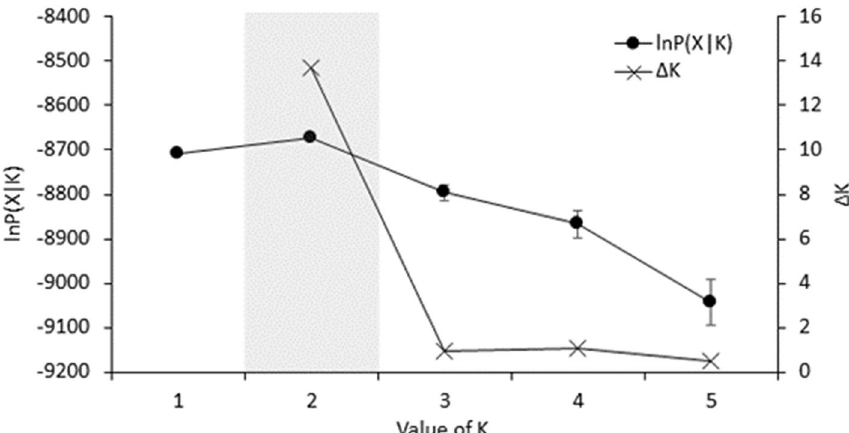
Figure 2. lnP(X|K; ± S.E.) and ΔK, as obtained in STRU CTU RE version 2.3.3, with K ranging from 1 through 5. Burn-in period was set to 50,000 simulations followed by 100,000 repetitions. Each value was obtained by averaging the posterior probabilities of 10 independent runs. Shaded region highlights the optimal value of K based on both approaches. Estimation of the optimal number of genetic clusters based on the Bayesian clustering analysis performed in STRU CTU RE and following two approaches 61,62 . The best-supported model was that of two genetic clusters as indicated by the maximum value of ΔK and the lowest standard error for lnP(X|K) at K =